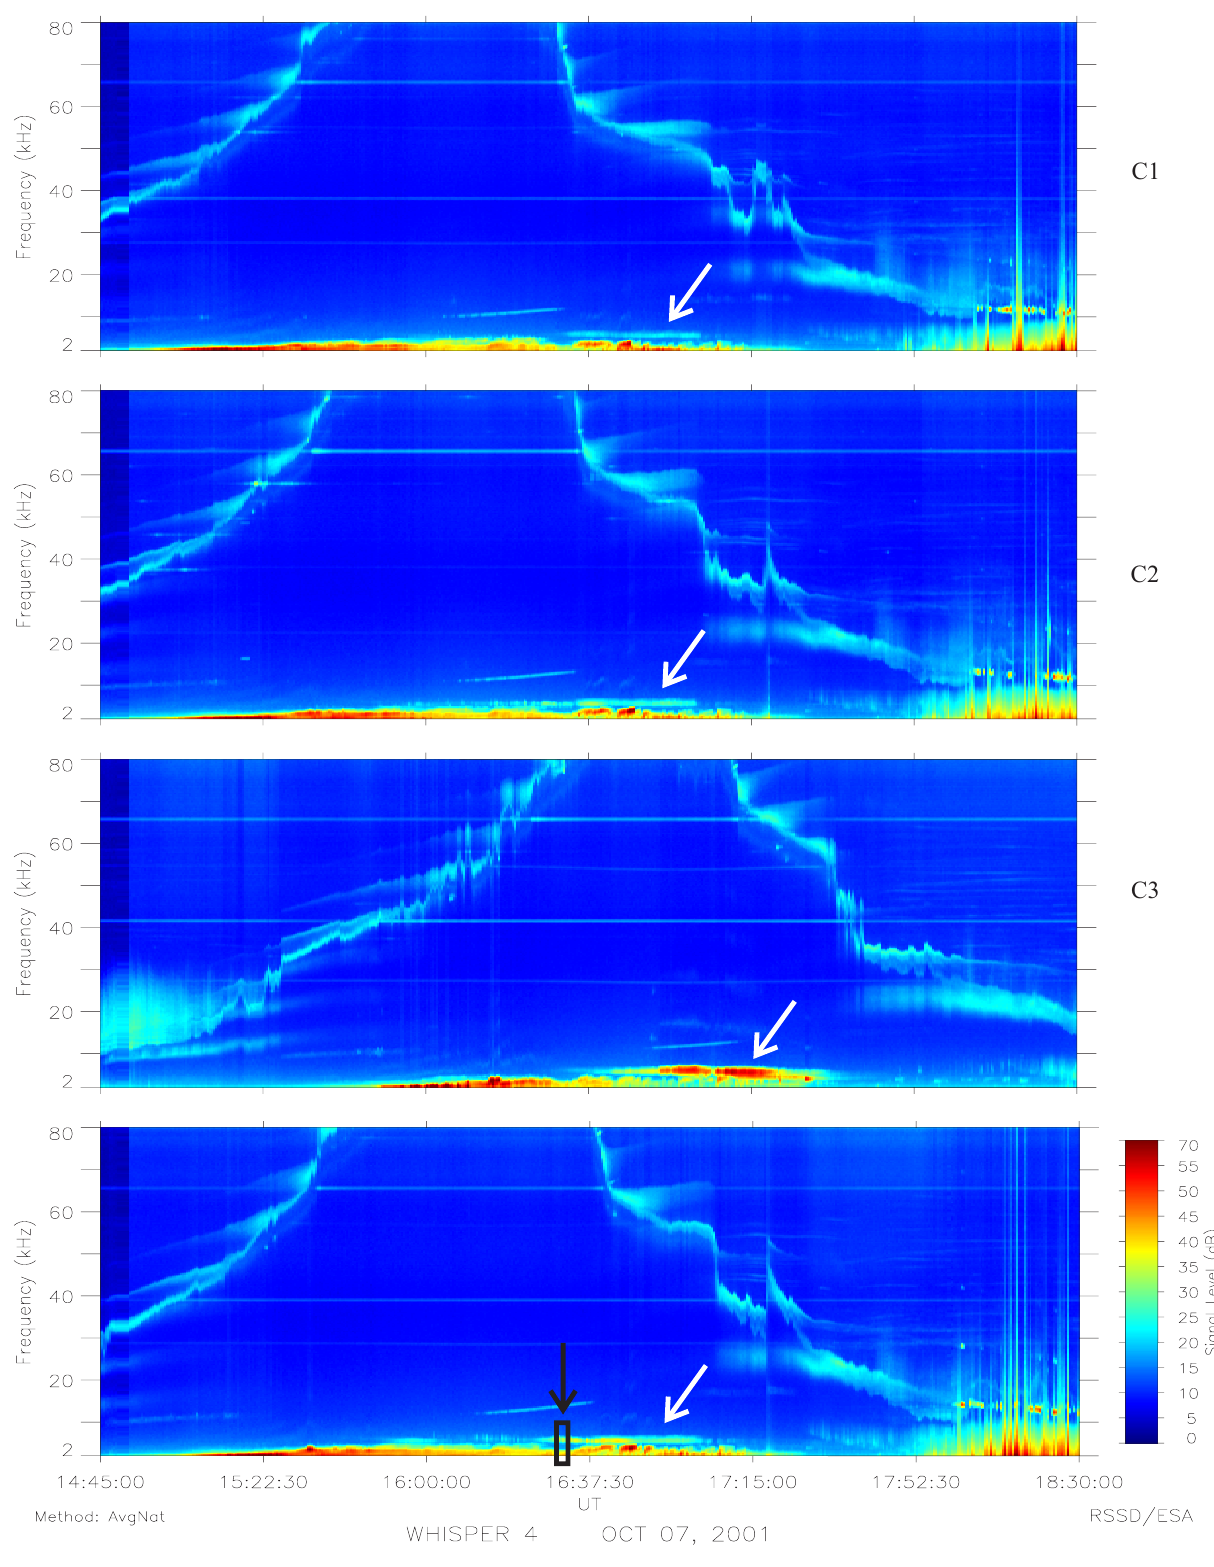
Fig. 1. From top to bottom, WHISPER spectrograms measured by C1 to C4 on 7 October 2001, from 14:45 UT to 18:30 UT. Note the presence of a banded hiss-like emission from 16:25 UT to 17:04 UT, pointed out by white arrows, which intensifies with altitude: C4 > C2 > C1 (see right panel of Fig. 3) and with time C3 (cid:29) C4 > C2 > C1. In the last panel, the black box, pointed out by a black arrow, symbolizes the time period and the frequency range of the enlargement displayed in Fig.